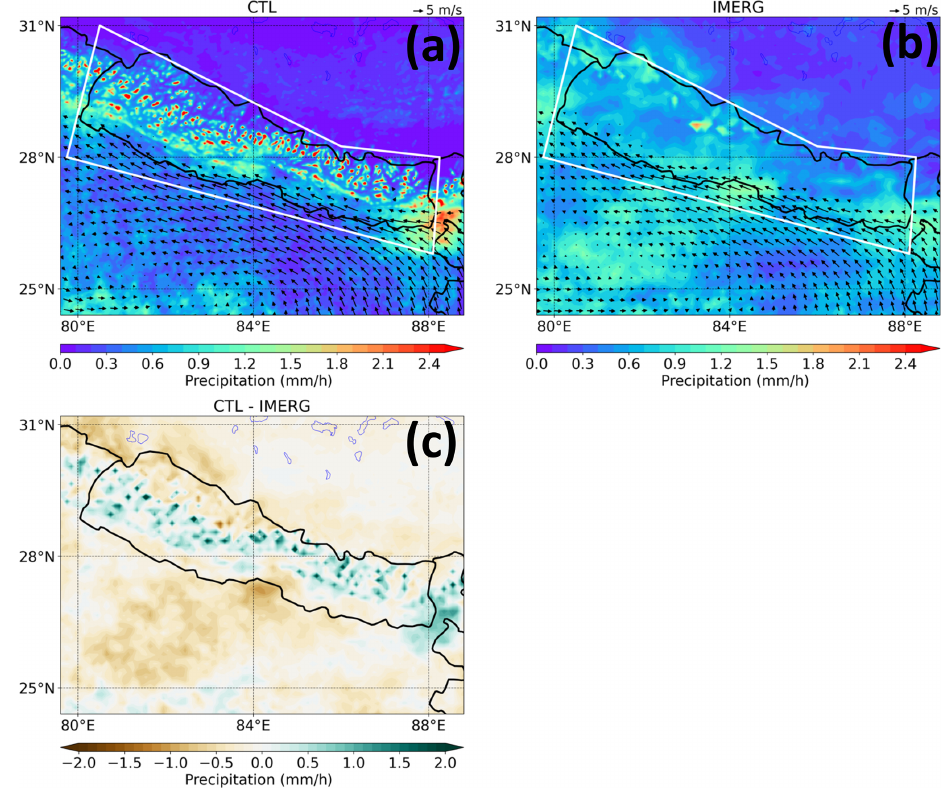
Figure 6. Hourly mean precipitation from (a) CTL (3km) with 925hPa wind vectors and (b) IMERG (0.1 ◦ ; ∼ 10km) with 925hPa wind from ERA5 ( ∼ 25km). (c) Mean hourly bias of CTL relative to IMERG. The white-colored polygon represents the CenHim. The 3km CTL precipitation is re-gridded to 10km resolution to match up with the IMERG spatial resolution using the bilinear interpolation